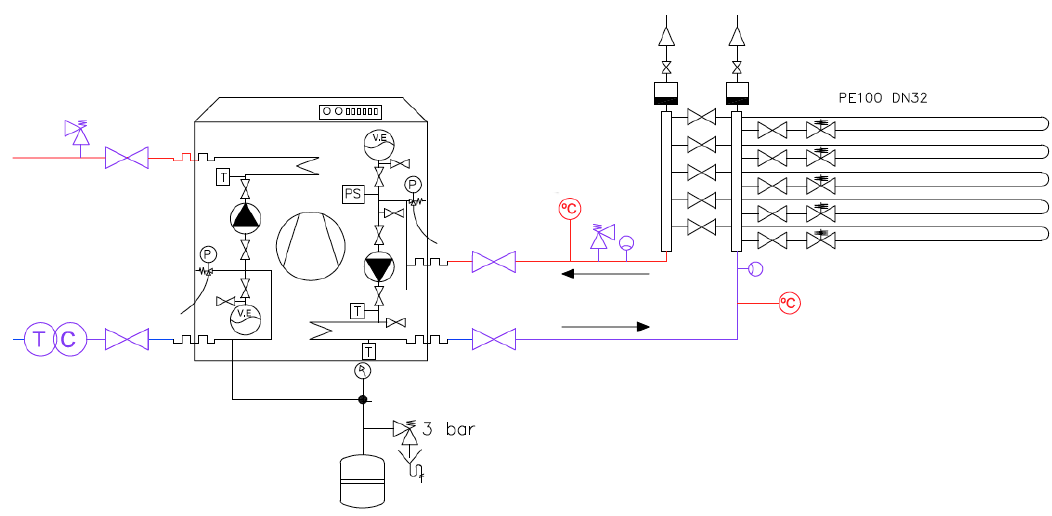
Figure 1. Heat pump and horizontal exchanger